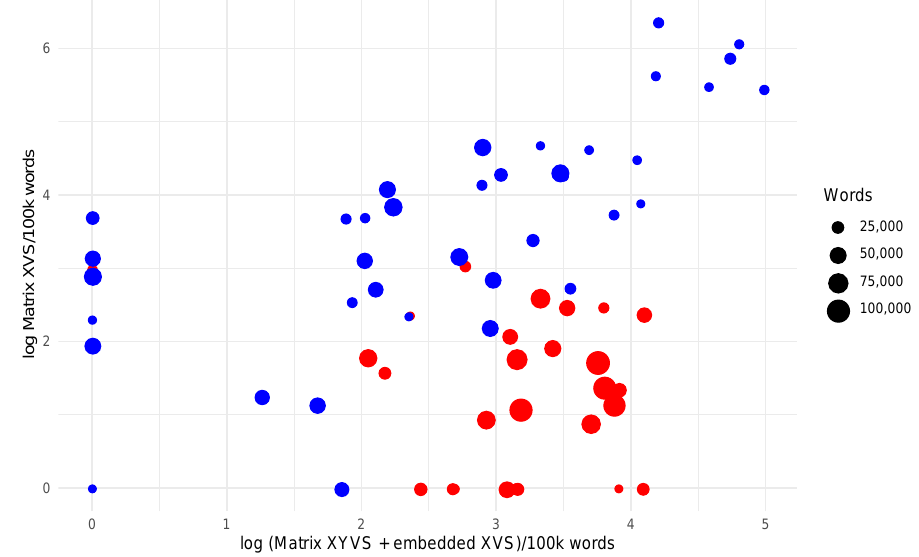
Figure 5. The data in Figure 4 split into Old English (red) and Middle English (blue) texts. The reason for this is plausibly that inversion in matrix clauses with pronominal sub‑ jects is almost categorically absent in surviving OE texts. 31 Accordingly, the lack of cor‑ relation among OE texts in Figure 5 could be a kind of floor effect: matrix inversion with pronominal subjects is so close to completely absent that it only features as